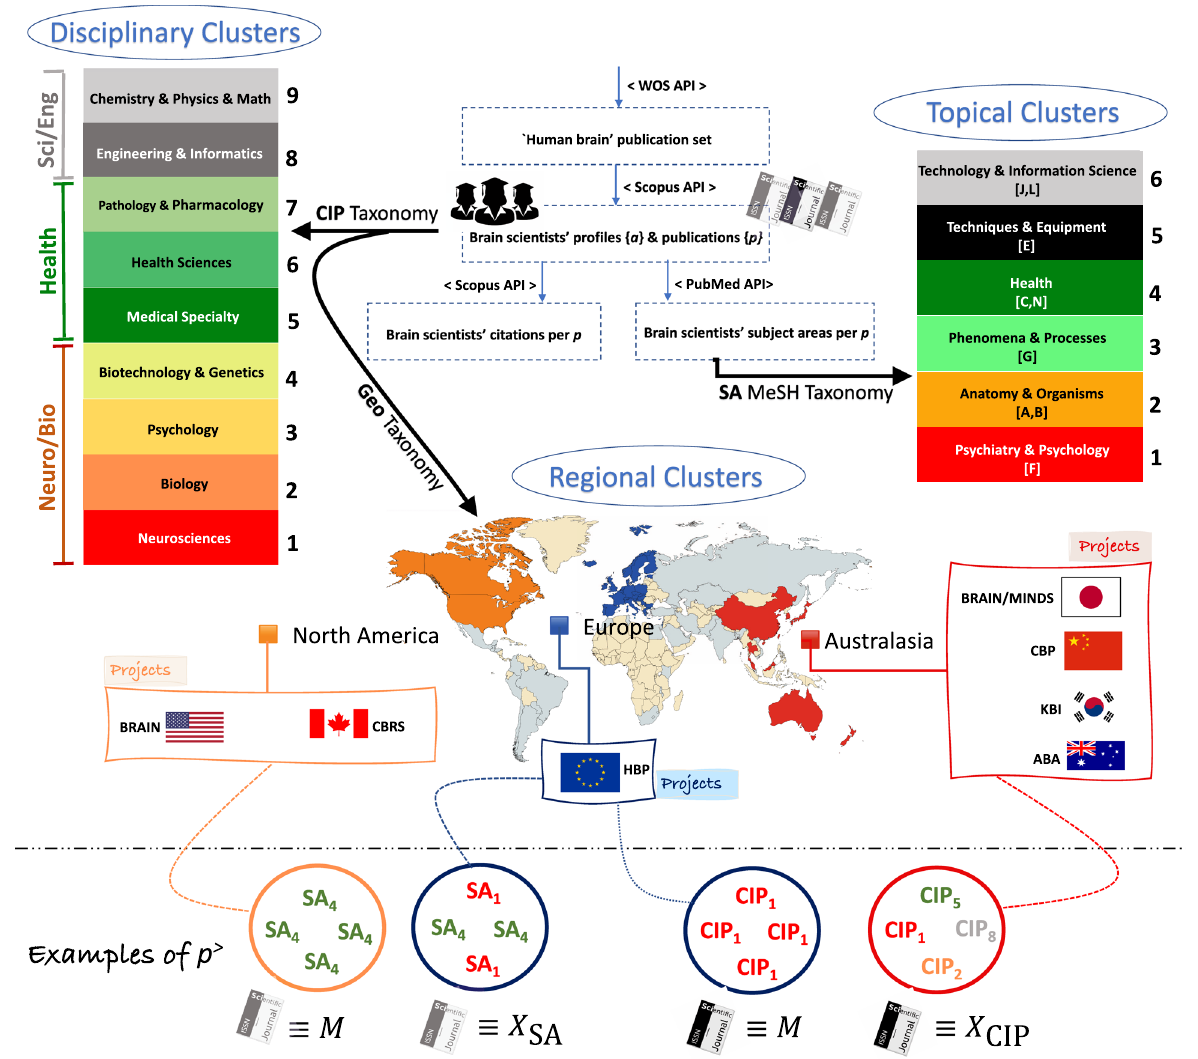
Fig. 1 Data collection and classi fi cation schemes. The upper part of the fi gure shows the data generation mechanism along with the resulting topical (SA) and disciplinary (CIP) clusters. The middle part of the fi gure shows on the world map regional clusters pertaining to three large HBS funding initiatives — North America (NA), Europe (EU), and Australasia (AA). The lower part of the fi gure shows an example of how all three categorizations are operationalized for analytic purposes. Circles represent four research articles with authorship from distinct regions. The articles feature different keyword (SA) or disciplinary (CIP) category mixtures assigned one of two diversity measures: mono-domain ( M ) and cross-domain ( X